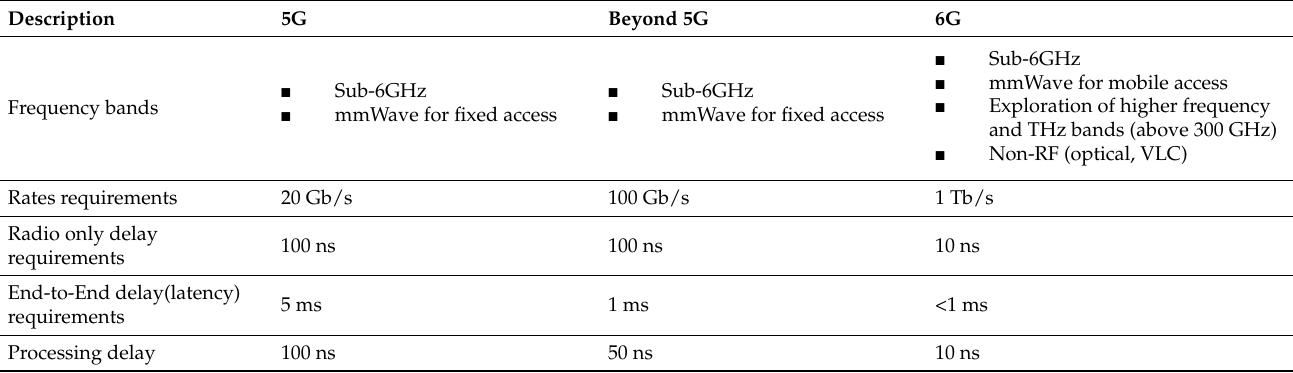
Table 3. A comparative analysis of 5G, B5G, and